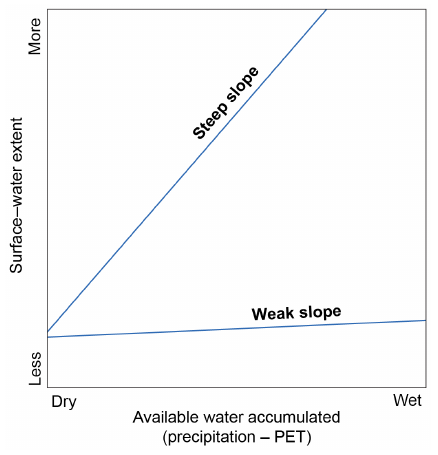
Figure 2. Theoretical figure showing the derived dependent vari- able, or the Surface Water Climate Response (SWCR), defined as the slope of the statistical relationship between accumulated wa- ter and surface water extent. Some areas show a greater SWCR or substantial increase in surface water extent as more water be- comes available via precipitation minus potential evapotranspira- tion (PET), while other areas show little to no change in surface water extent, presumably as excess water leaves the system through runoff or